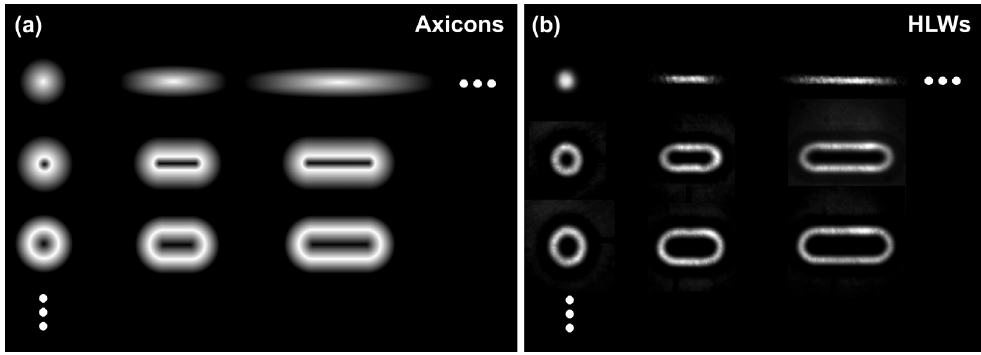
Figure 5. Flexible generation of few-cycle light bullets with the characteristics of spatially oscillation-free, temporally nondiffracting highly localized wavepackets (HLWs): ( a ) gray value distributions corresponding to the phase maps of axicons; ( b ) measured time-integrated intensity maps of a set of simultaneously formed light bullets of different spatial structures in a transversal plane (disks, lines, rings and stadiums). Both the new types of shaping phase elements and the HLWs represent generalizations of the conventional approaches of axicons and nondiffracting beams, respectively. Arrays of programmable HLWs enable to realize time-wavefront sensors with spatially encoded spots and flexible array geometries.